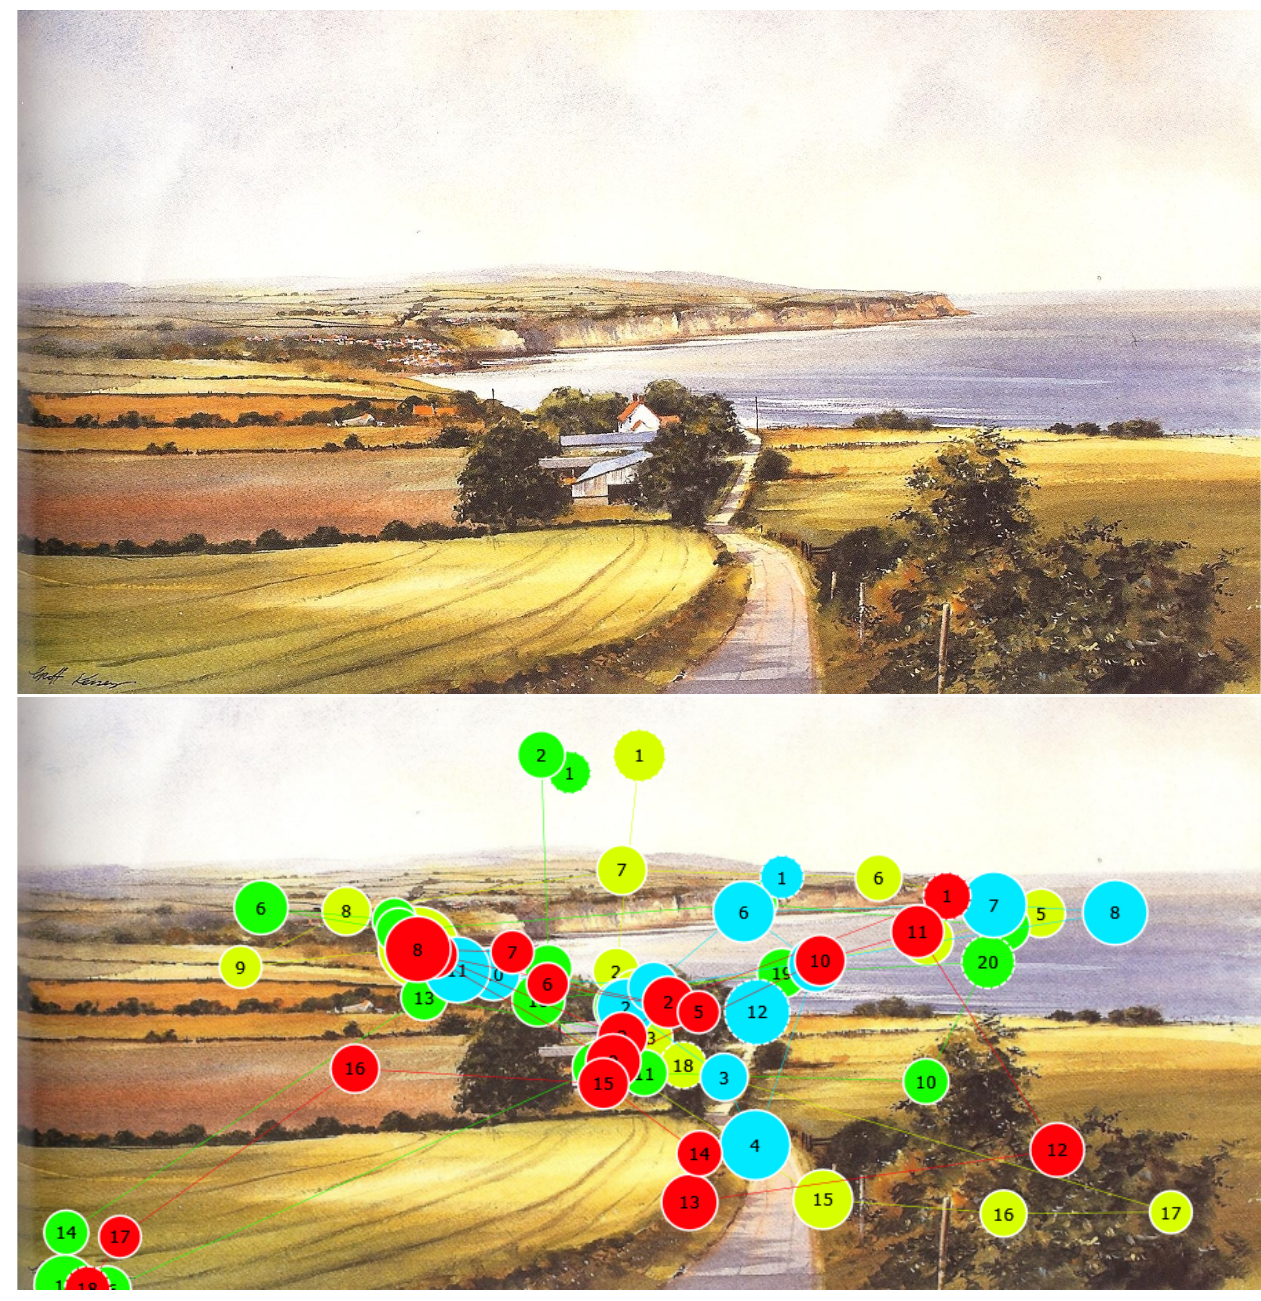
Figure 2. Gazeplots over Painting 1, Looking towards Robin’s Hood Bay (Source: Kersey,